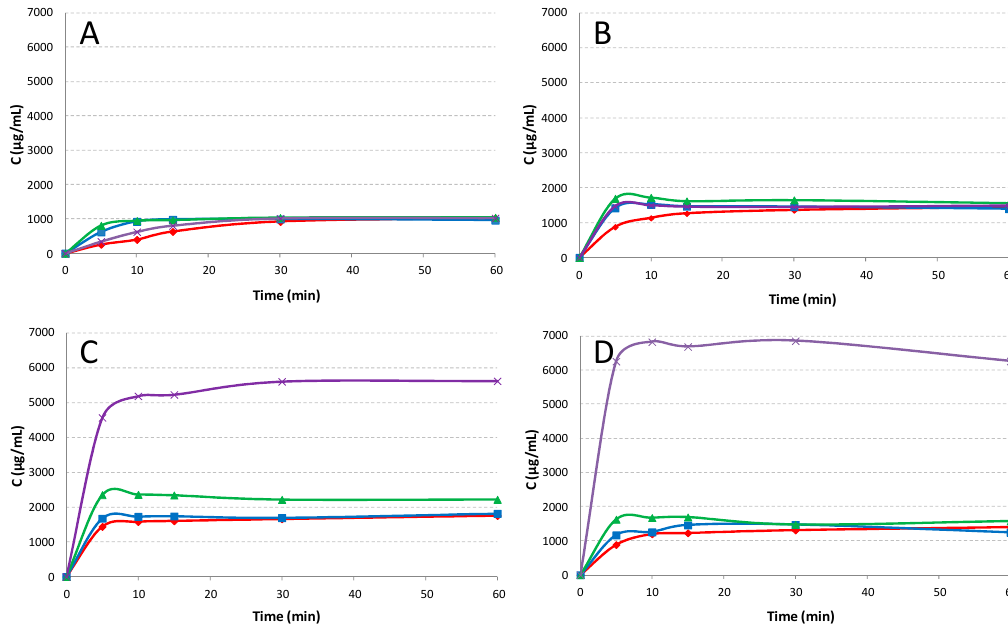
Figure 4. Dissolution profiles of pure HCT ( A ) untreated ( (cid:7) red line) or submitted to kneading ( (cid:4) blue line), grinding ( (cid:78) green line), or dissolution-solvent evaporation (x violet line) and from its binary systems with β CD ( B ), SBE β CD( C ), and RAMEB ( D ), obtained by physical mixing (PM) ( (cid:7) red line), kneading (KN) ( (cid:4) blue line), co-grinding (GR) ( (cid:78) green line), and co-evaporation (COE) (x violet line). Each value represents the mean of 3 experiments.